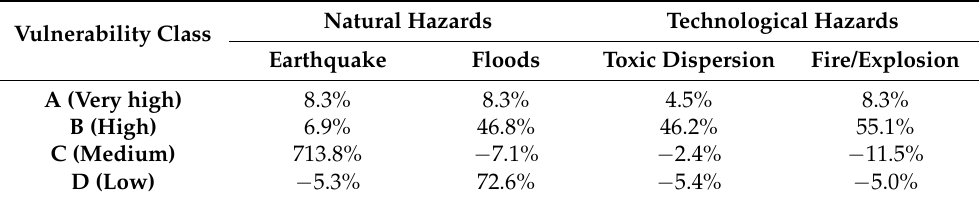
Table 4. Summary of vulnerability level variation between 2006 and 2018 in Oradea FUA.